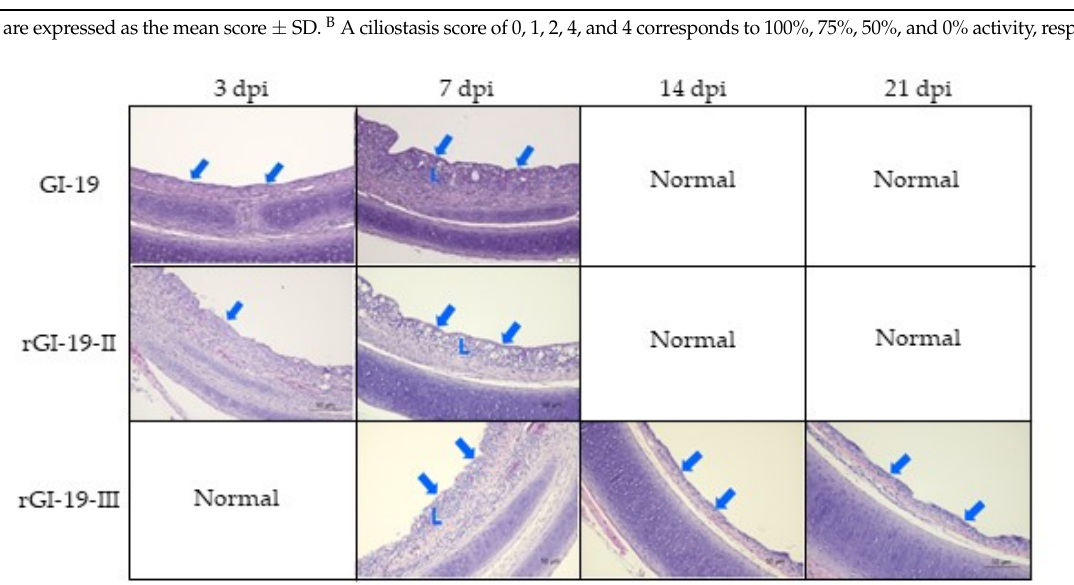
Figure 5. IBV viral load in different tissues (trachea ( A ), kidney ( B ), and cecal tonsil ( C )) from chick- ens, as measured by RT-qPCR. The error bars represent the standard deviation. *: Negative result may be due to errors during sample processing. #: p < 0.05; ##: p < 0.01; ###: p < 0.001.